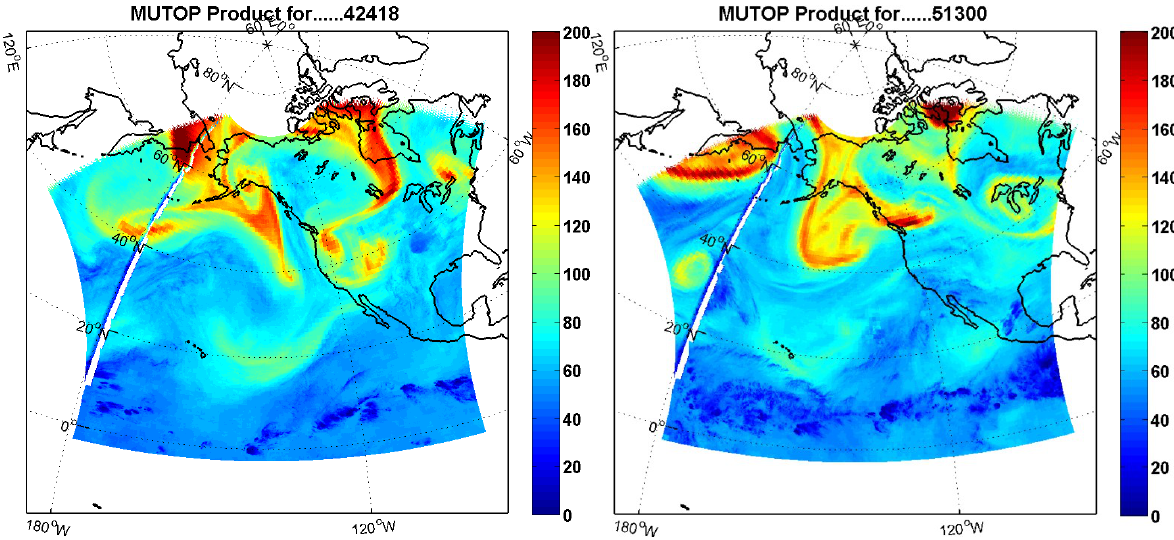
Fig. 1. These sample MUTOP images map the TES-derived multi-sensor upper-tropospheric ozone product which characterizes the UT layer-average (300–500hPa) volume mixing ratio of ozone in ppbv over the GOES west domain domain for two dates, (a) at 18:00UTC on 24 April 2006 and (a) at 00:00UTC on 13 May